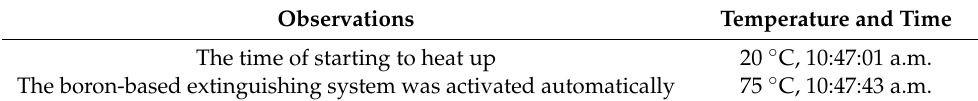
Table 5. Exp. B.2 results.